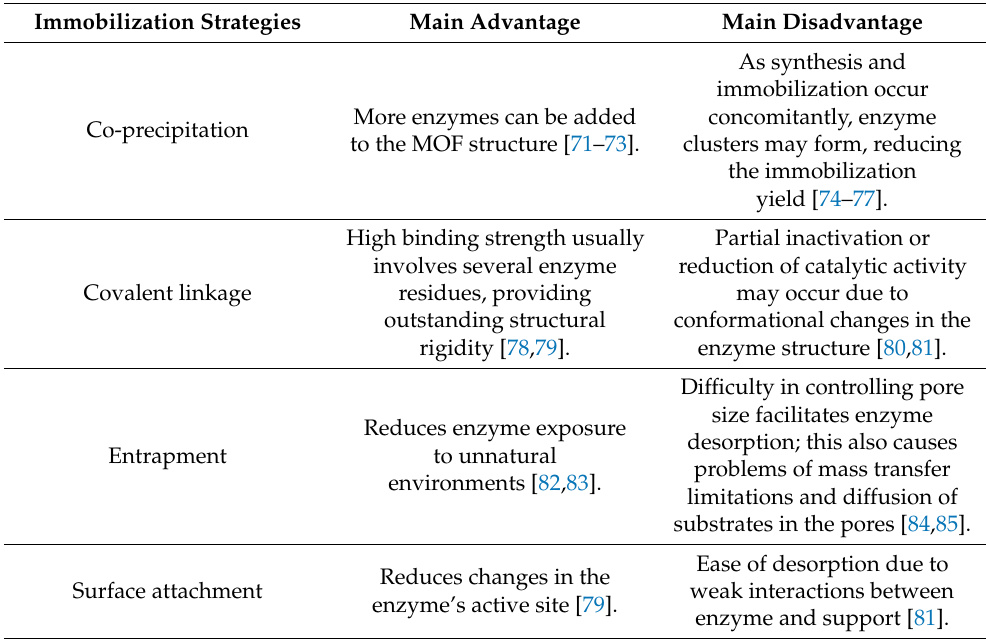
Table 1. Different methods of enzymatic immobilization on MOFs and their main advantages and disadvantages. Synthesis of Metal–Organic Frameworks (MOFs) for Enzyme Immobilization Immobilization Strategies Main Advantage